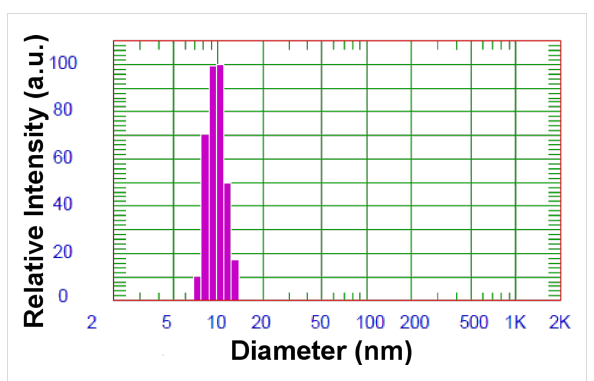
Figure 2: DLS results of the diameter distribution of the resulting nanoparticles formed in a solution with a standard composition.